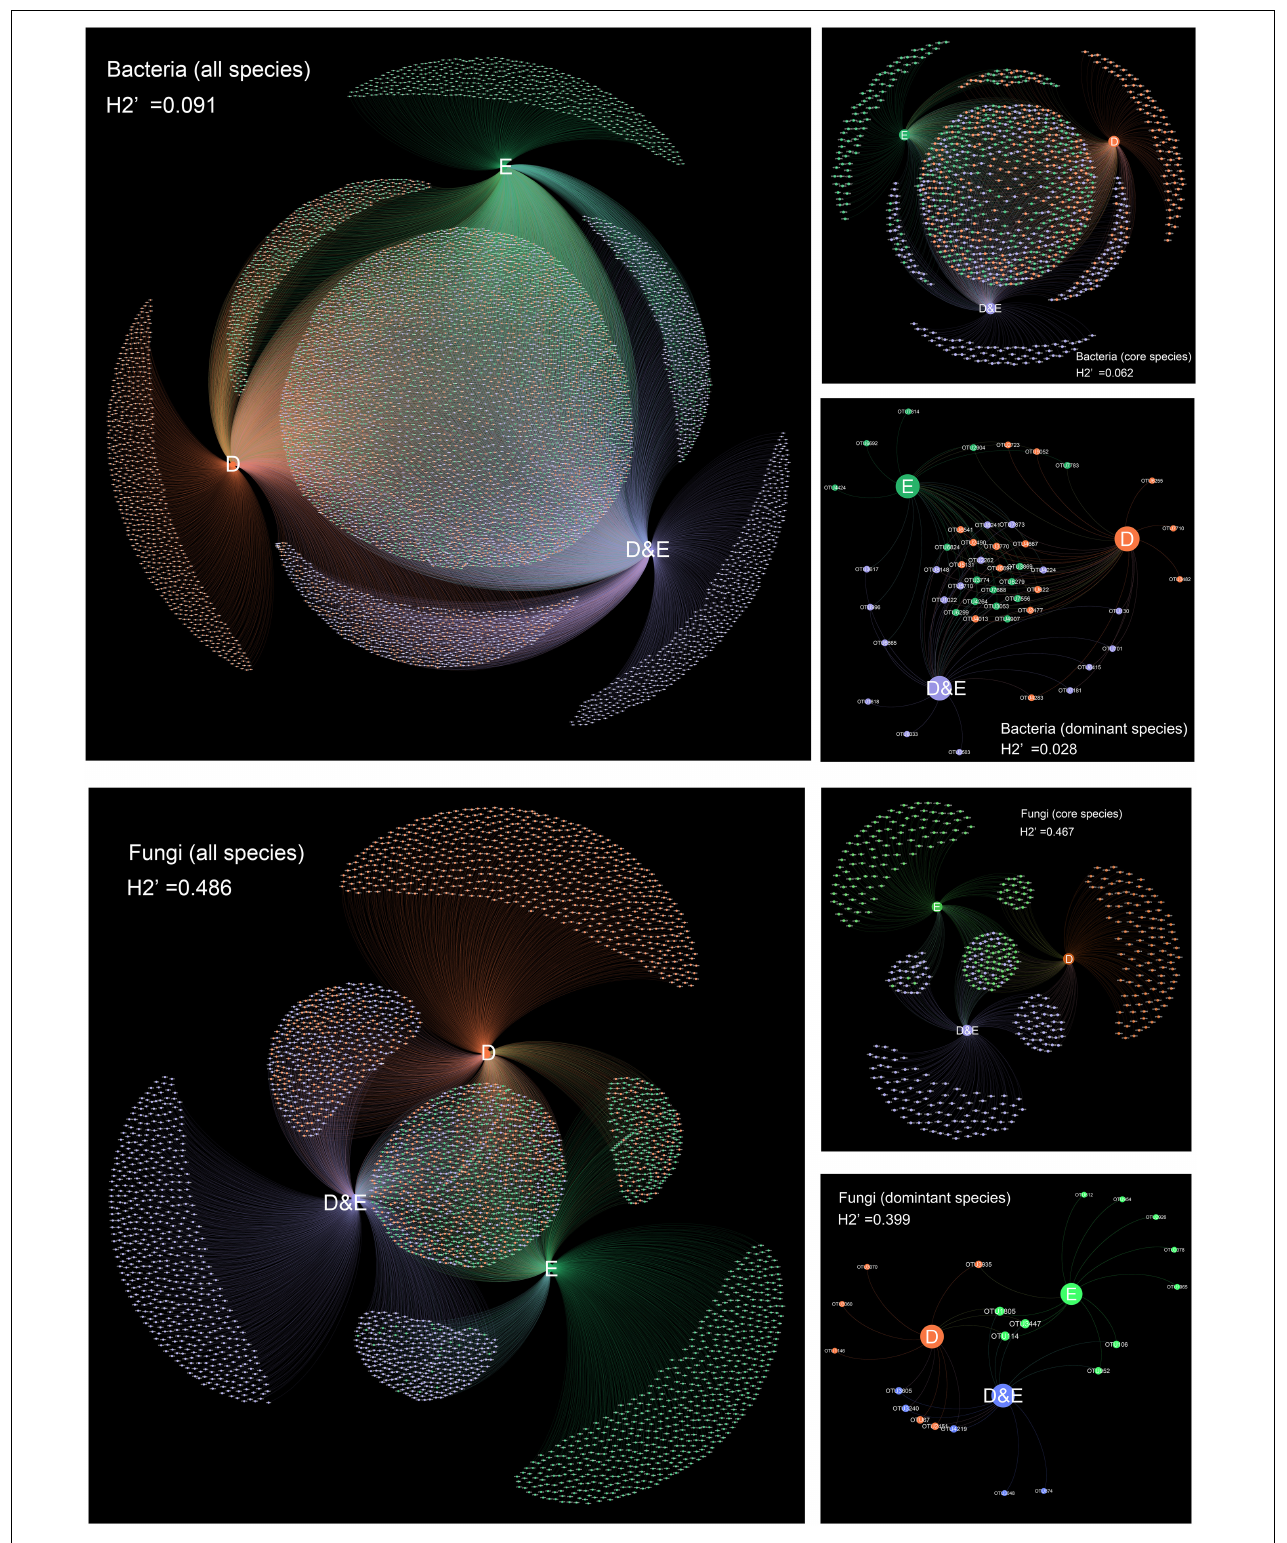
FIGURE 3 | Microbial community network relationships among different vegetation types in the temperate urban forest in China. D is the deciduous forest, E is the evergreen forest, D&E is the deciduous and evergreen mixed forest. Each circle represents an OTU, different colors represent different vegetation types, and the circle size represents OTU richness. H2’ is the specialization